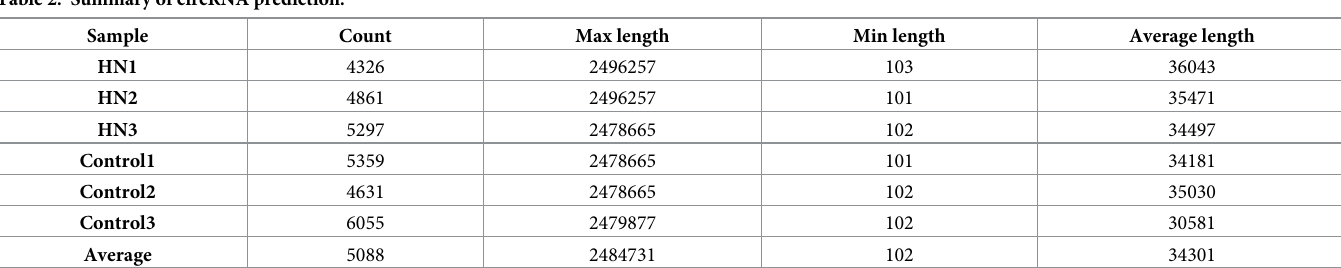
Table 2. Summary of circRNA prediction.